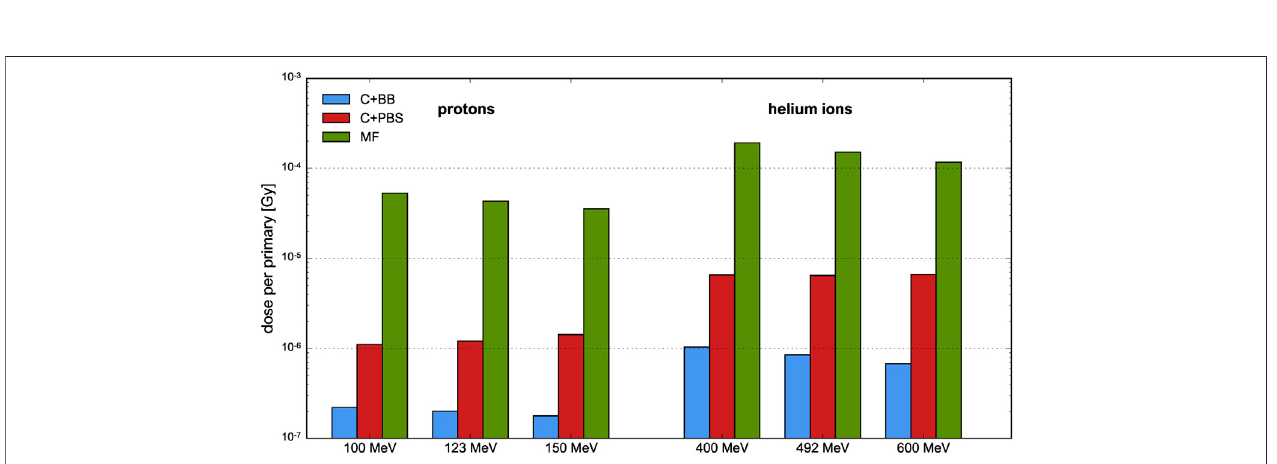
FIGURE 6 | Ef fi ciency of proton and helium ion beams at different beam energies and for different minibeam techniques. The uncertainty bars are very small and barely visible.